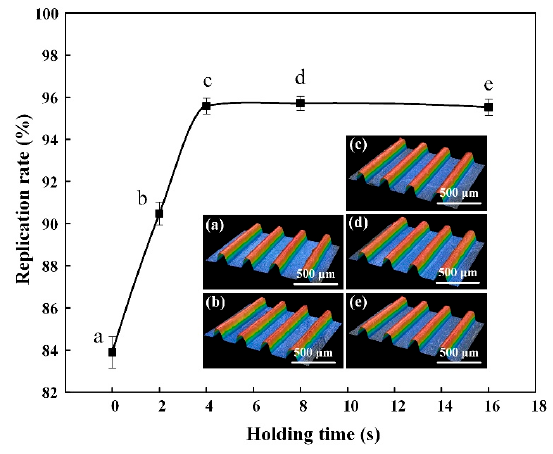
Figure 7. The replication rate of micro-structure at different holding times and three-dimensional profile: ( a ) 0 s; ( b )2 s; ( c ) 4 s; ( d ) 8 s; ( e ) 16 s.